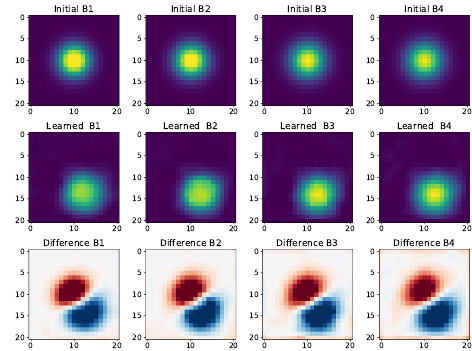
Figure 10. Learned filters in the MTF module of the BCNet architecture, Aude1 case. The module learns both mis-registration and MTF residual, cancelling them for the downstream MLP. Kernels are sampled at 2m